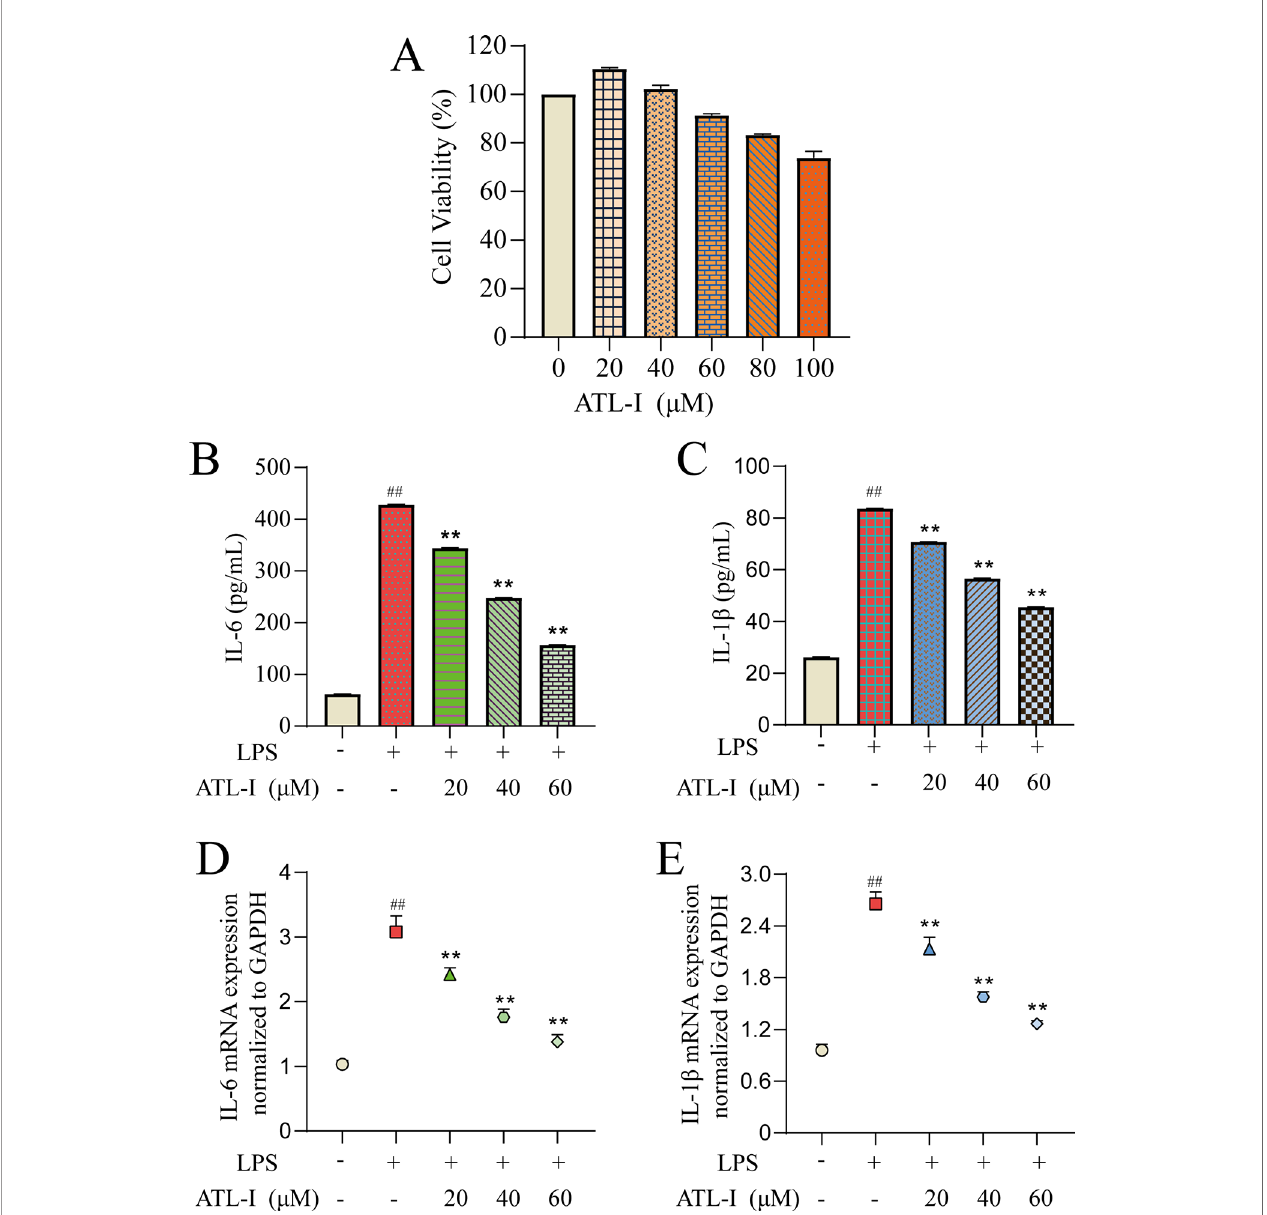
FIGURE 6 | Action of ATL-I on RAW264.7 cells. RAW264.7 cells were incubated with LPS (1 m g/mL) for 24 h and then treated with ATL-I (20, 40, or 60 m M) for 24 h. The effects of ATL-I (A) on the viability of RAW264.7 cells using the CCK-8 assay. Production of IL-6 (B) and IL-1 b (C) was determined by ELISAs. Protein expression of IL-6 (D) and IL-1 b (E) was determined by qRT-PCR. ## p < 0.01 versus blank control group. ** p < 0.01 LPS-treated